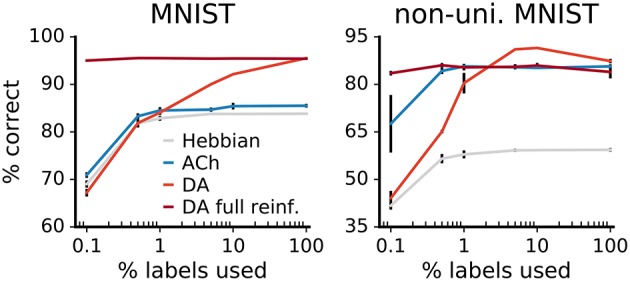
Comparison of label reliance for ACh and DA. Network performance as a function of the percentage of training labels used. For “DA full reinforcement” we use the indicated portion of labels to train the classifier but use all labels to provide the reward feedback. The size of the gains deriving from ACh are not statistically different from each others for any label fractions (p > 0.01). Data are the mean of 3 runs, error bars indicate the standard deviation.